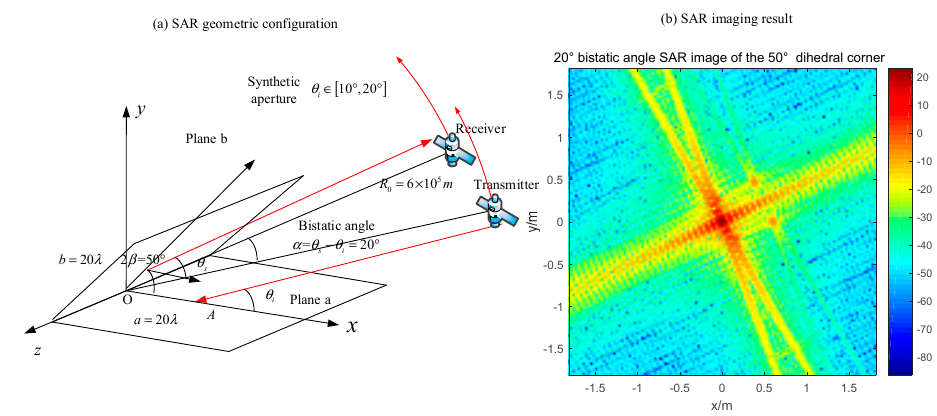
Figure 25. 20° bistatic angle SAR image of a 50°dihedral angle ( a ) geometric configuration; ( b ) Figure 25. 20 ◦ bistatic angle SAR image of a 50 ◦ dihedral angle ( a ) geometric configuration; imaging result. ( b ) imaging result.